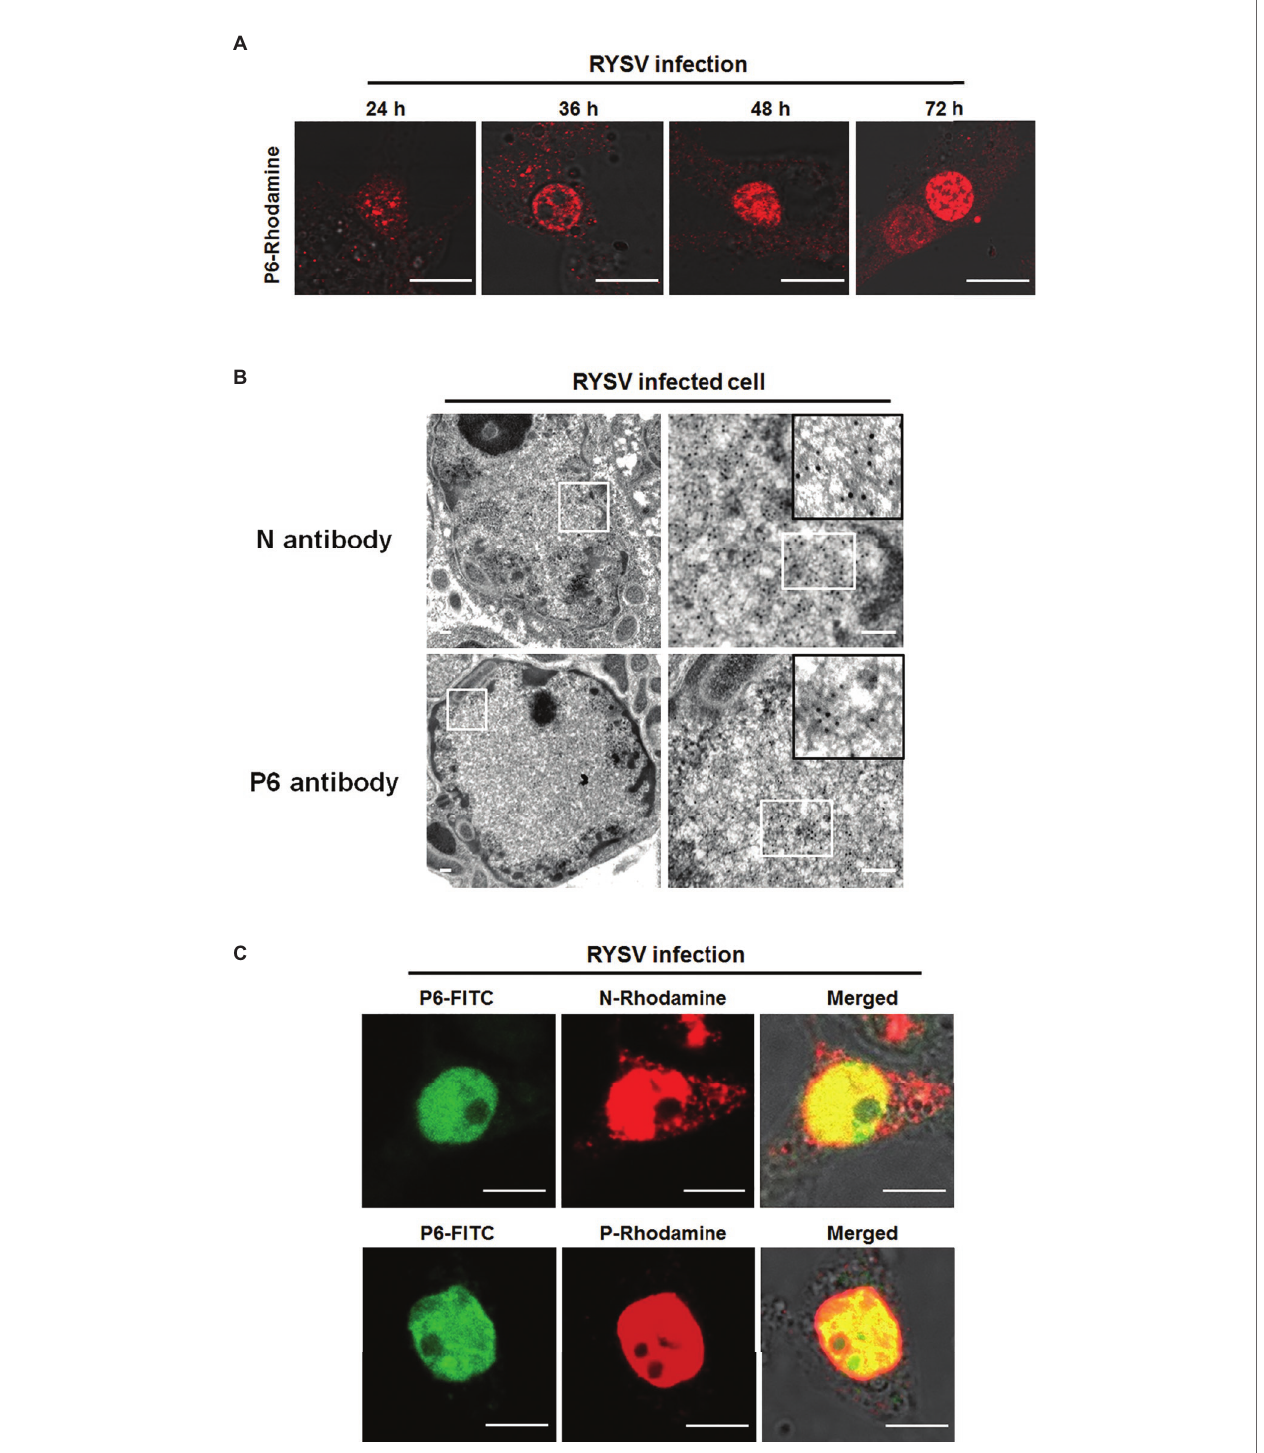
FIGURE 4 | Subcellular localization of P6 proteins of RYSV in viral-infected VCMs. (A) Morphogenesis of RYSV P6-formed structure in the nucleus of the RYSV- infected N. cincticeps cell at different time points of RYSV infection. VCMs infected by RYSV were labeled with antibody specific to RYSV P6. Scale bar: 20 μm. (B) Electron micrographs showing subcellular localization of RYSV P6 in RYSV-infected VCMs. Samples were immunolabeled with P6-specific polyclonal antibodies as primary antibodies and then treated with goat-anti-rabbit IgG conjugated to 15-nm-diameter gold particles as secondary antibodies. RYSV-infected VCMs were labeled with N-specific antibody separately, as a control. Scale bar: 100 nm. (C) Confocal immunofluorescence micrographs showing the colocalization of the P6 protein and the N and P proteins in the RYSV-infected N. cincticeps cell. Scale bar: 20